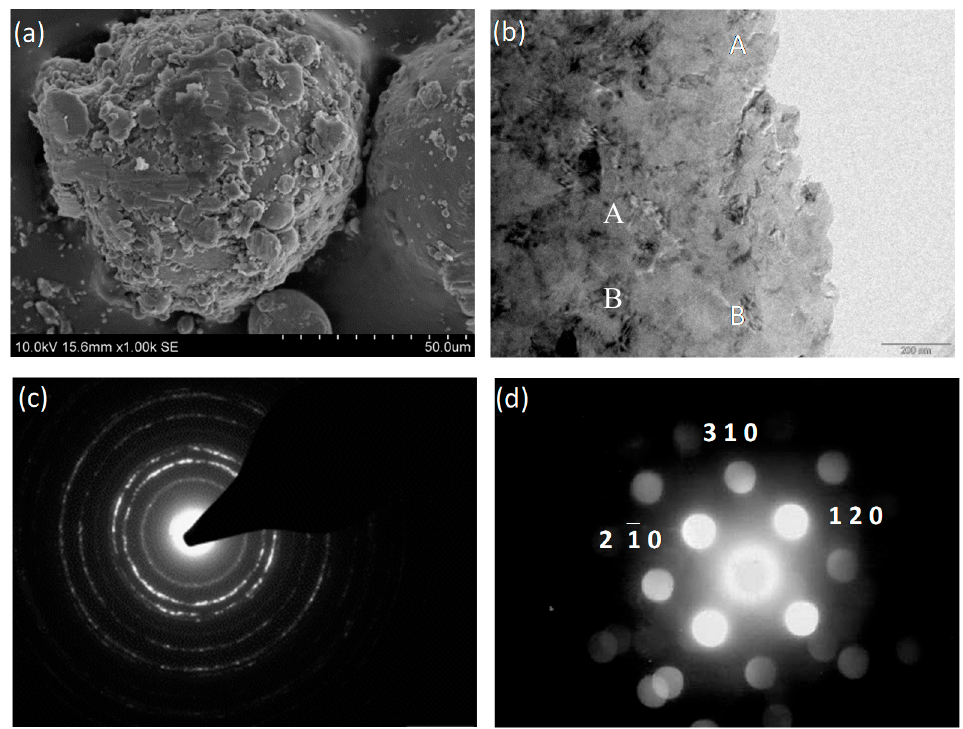
Figure 4. ( a ) Al-12Si/AlN powder SEM micrograph; ( b ) TEM bright field (BF) micrograph of Al-12Si/AlN particle surface; ( c ) ED of Al-12Si/AlN, Zone A; ( d ) ED of Al-12Si/AlN, Zone B. Metals 2020 , 10 , x FOR PEER REVIEW